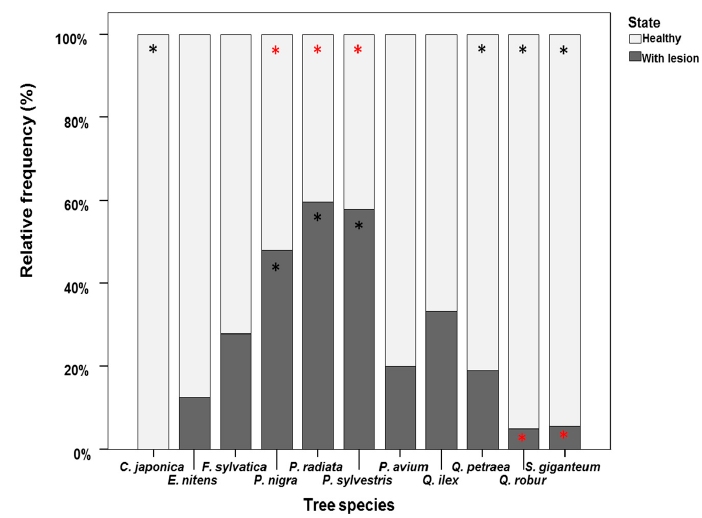
Figure 9. Susceptibility of several tree species found in the Basque Country to A. mellea infection. The relative frequency of healthy young trees and those with fungal lesions was determined four months after infection with A. mellea and growth under greenhouse conditions. Counts are represented as percentage of the total number of plants for each tree species. Black asterisks indicate positive significant z scores ( p < 0.05). Red asterisks indicate negative significant z scores ( p < 0.05).